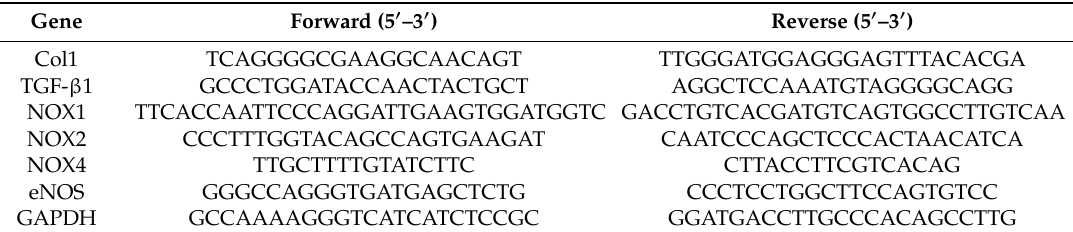
Table 1. The primers used for real-time